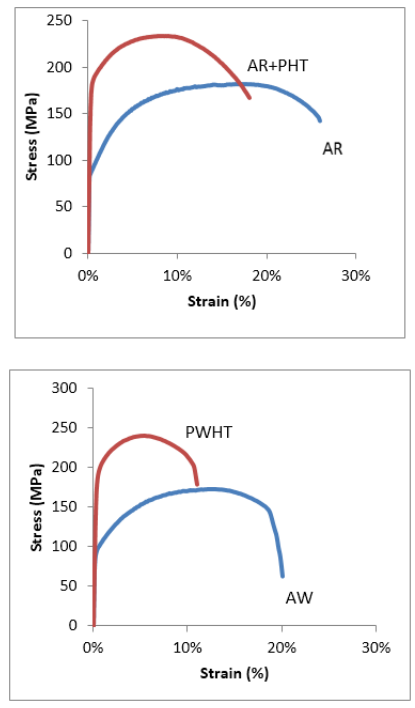
Figure 10. Stress-strain response of 9.5 mm (3/8 in) thick extrusion of AA6061 in the as-received (AR), as-received plus precipitation heat treated (AR+PHT), as-welded (AW) and post weld heat treated (PWHT) conditions.